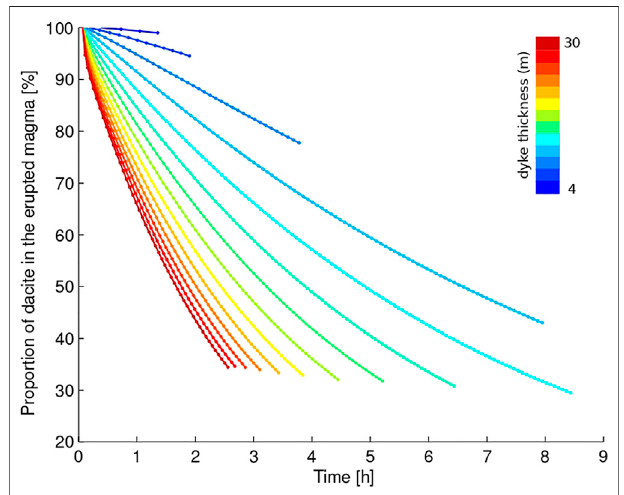
FIGURE 9 | Calculated evolution of the average composition of the erupted magma, for the same simulation cases as in Figure 7 .